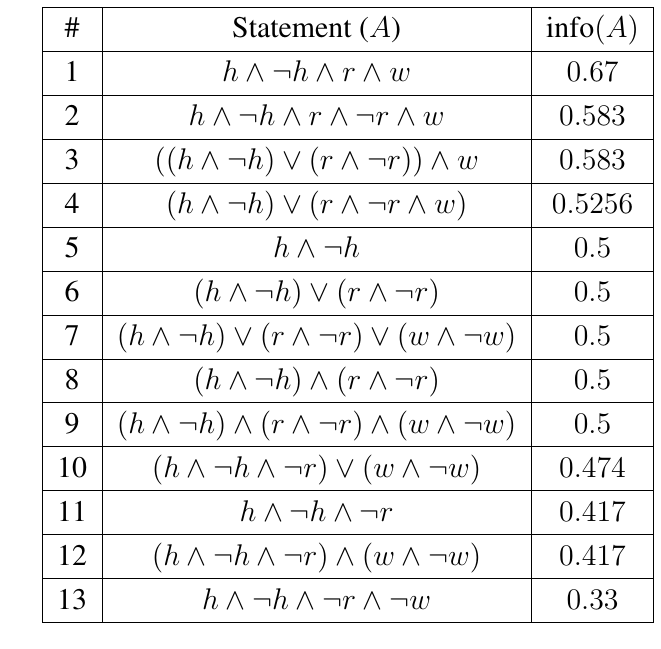
Table 8. Results for